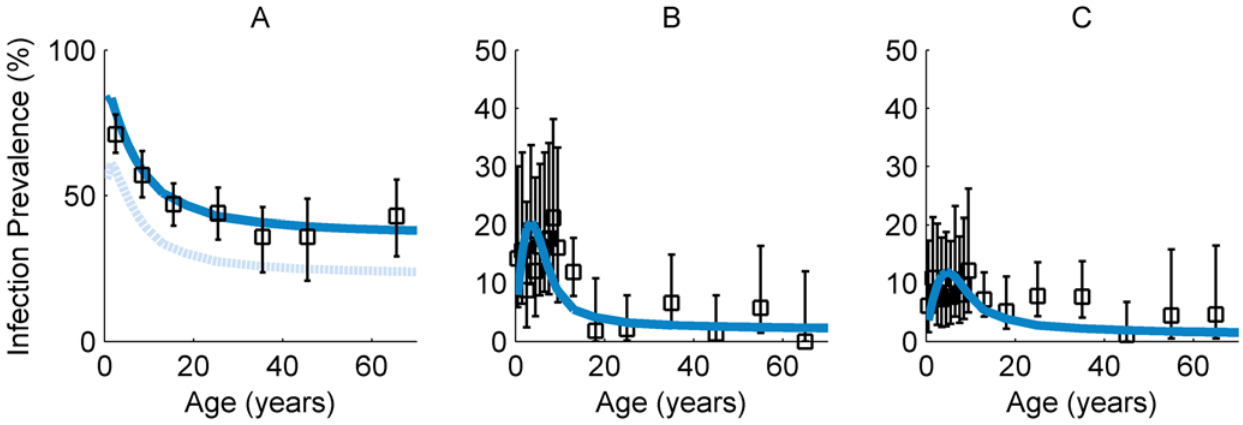
Figure 4. Model fits to data from three endemic settings. Age-profiles of the prevalence of infection generated by fitting the model (solid lines) to the data (squares and 95% confidence interval error bars) from (A) Kongwa, Tanzania [25] (B) Rombo, Tanzania [24] and (C) Upper Saloum, The Gambia [22]. The dotted line in (A) corresponds to a model-fit to the data from Kongwa, Tanzania assuming a lower number of true infection positives, namely those that were determined to harbour chlamydial loads as measured by quantitative PCR (see main text and Text S1). Note the different scale on the y-axis of (A) in comparison to (B) and (C).